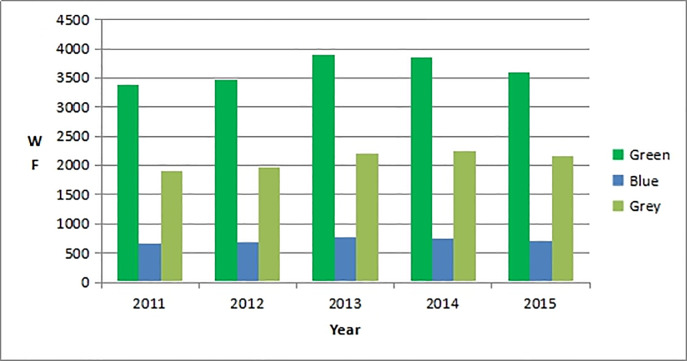
Green water footprint, blue water footprint, and grey water footprint of China in 2011–2015.(: WF is the water footprint; the units are in billions of cubic meters.).